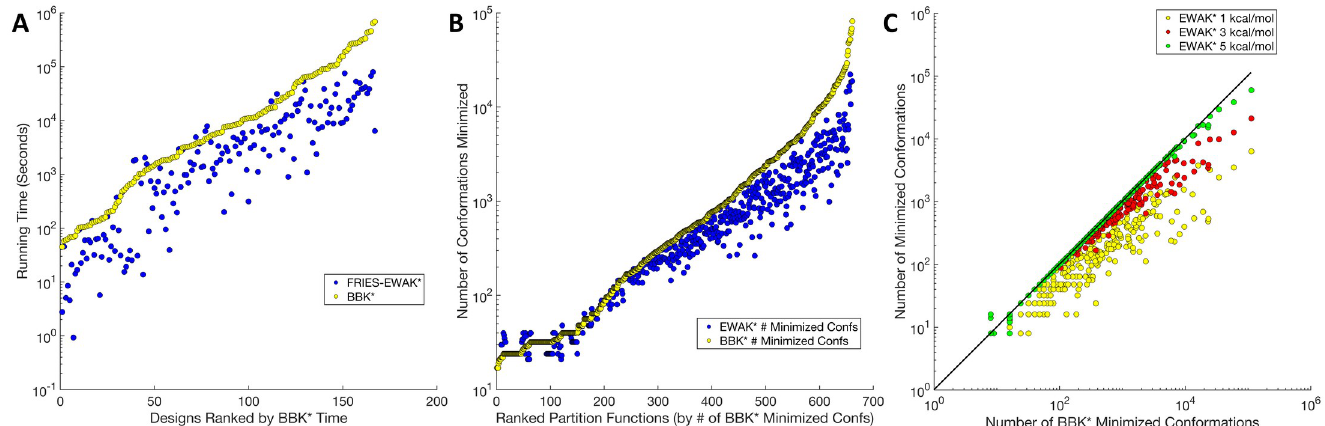
Fig 4. Comparing runtimes and the number of minimized conformations between FRIES / EWAK � and BBK � for a variety of designs. (A) A plot of the runtime in seconds (the y -axis is on a log scale) for FRIES / EWAK � (blue dots) and BBK � (yellow dots) for 167 design examples. Each point represents one design and is plotted in increasing order of BBK � running time. FRIES / EWAK � was faster than BBK � 92% of the time with an average improvement of 62% over BBK � and a maximum improvement of 2.2 orders of magnitude. This improvement was evident in (A) since the blue dots ( FRIES / EWAK � times) fall mostly below the yellow dots ( BBK � times). (B) A plot of the number of conformations minimized ( y -axis is on a log scale) for 661 partition function calculations from 161 design examples. The number of conformations minimized by EWAK � (blue dots) was less than the number of conformations minimized by BBK � (yellow dots) in 68% of these cases, as is evidenced by the blue dots landing mostly below the yellow dots. In the best case, EWAK � decreased the number of conformations by 1.1 orders of magnitude. The average percent reduction in the number of minimized conformations was 27%. (C) Each dot represents a calculated partition function. Yellow dots are partition functions limited to within a 1.0 kcal/mol window of the GMEC, red dots are partition functions limited to a 3.0 kcal/mol window of the GMEC, and green dots are partition functions limited to within a 5.0 kcal/mol window of the GMEC. These dots are plotted according to the number of minimized conformations required for each corresponding BBK � partition function calculation. The solid black line represents the number of BBK � minimized conformations, so dots that fall below the black line represent examples that required fewer minimized conformations than with BBK � . As they approach the 5.0 kcal/mol window, the dots begin to converge with the BBK � line. However, as the number of BBK � minimized conformations rises beyond � 10 4 , even the green dots drop below the BBK � line.